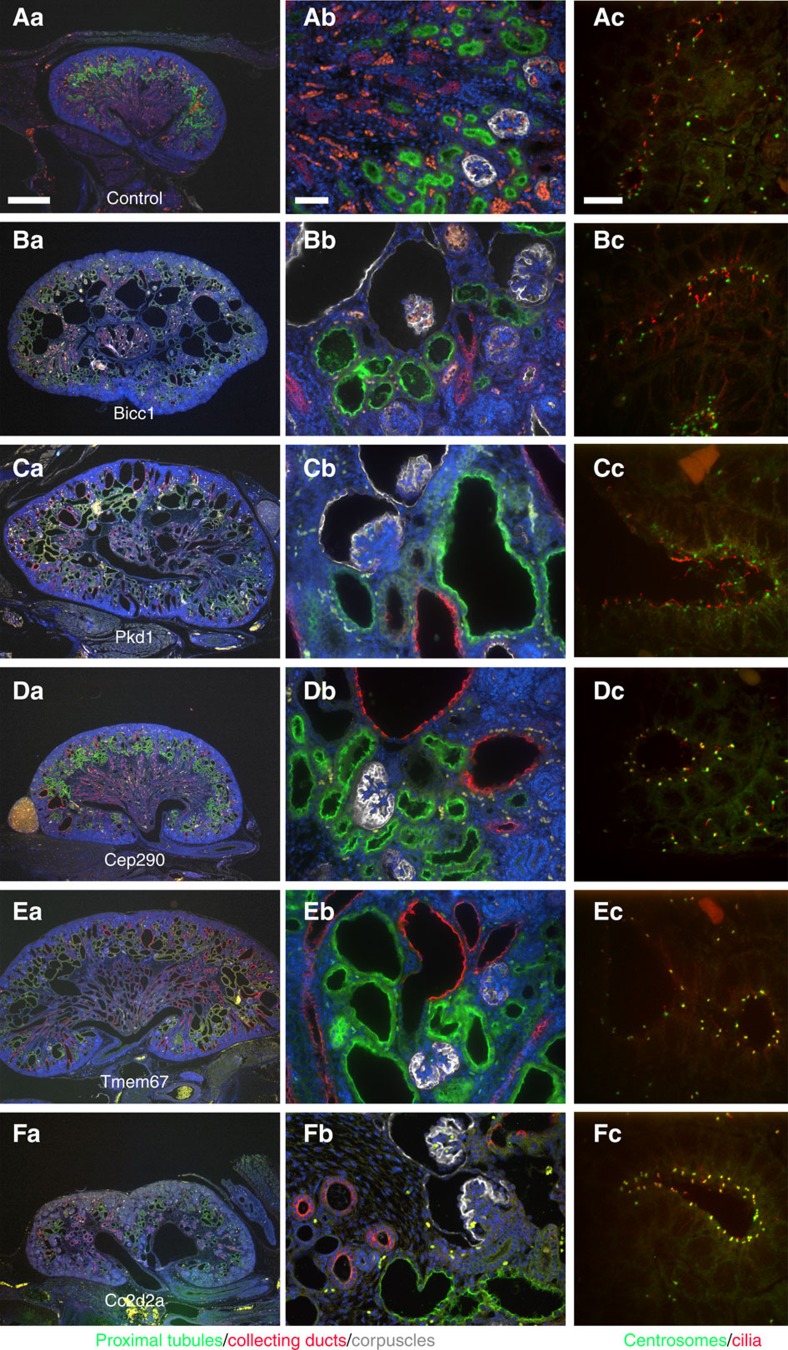
Severe cystic kidney disease.(Aa,Ab,Ba,Bb,Ca,Cb,Da,Db,Ea,Eb,Fa,Fb) Kidneys stained with LTA (green), aquaporin-2 (red), T1α (grey) and DAPI (4,6-diamidino-2-phenylindole; blue), to mark proximal tubules, collecting ducts, renal corpuscles and nuclei, respectively. It is noteworthy that the large cysts in the medulla of the Bicc1 line (B) are positive for T1α, indicating that they are derived from the renal corpuscle, whereas the small cysts/dilations are derived from proximal tubules. The Pkd1 line (C) has dilations and cysts in the renal corpuscles, nephrons and collecting ducts. Cep290 mutants (D) have primarily collecting duct cysts but also show some dilation of the proximal tubules. Tmem67 lines (E) are similar to the Cep290 presentation, except that the proximal tubule is more affected. Similarly, the Cc2d2a line (F) shows collecting duct and proximal tubule dilations along with glomerular cysts. The glomerular cysts were observed in individuals without hydronephrosis, suggesting that they are part of the phenotype and not a secondary effect of hydronephrosis. Scale bar, 500 μm (a) 50 μm (b). (Ac,Bc,Cc,Dc,Ec,Fc) Kidneys stained for centrioles (γ-tubulin, green) and cilia (Arl13b, red). The cilia in Bicc1 (Bc) and Pkd1 (Cc) mutant kidneys looked similar to wild type and no significant difference was seen in per cent ciliation in these lines. Cep290 (Dc), Tmem67 (Ec) and Cc2d2a (Fc), all greatly affected ciliation. Tmem67 and Cc2d2a caused a remarkable reduction in per cent ciliation and the cilia that remained were short stubs. Cep290 was more variable in presentation. It did not have a great effect on per cent ciliation in the ureteric bud tip but did cause a dramatic shortening of the cilia on these cells. Long cilia could be found in other cell types in the kidney. Scale bar, 10 μm.